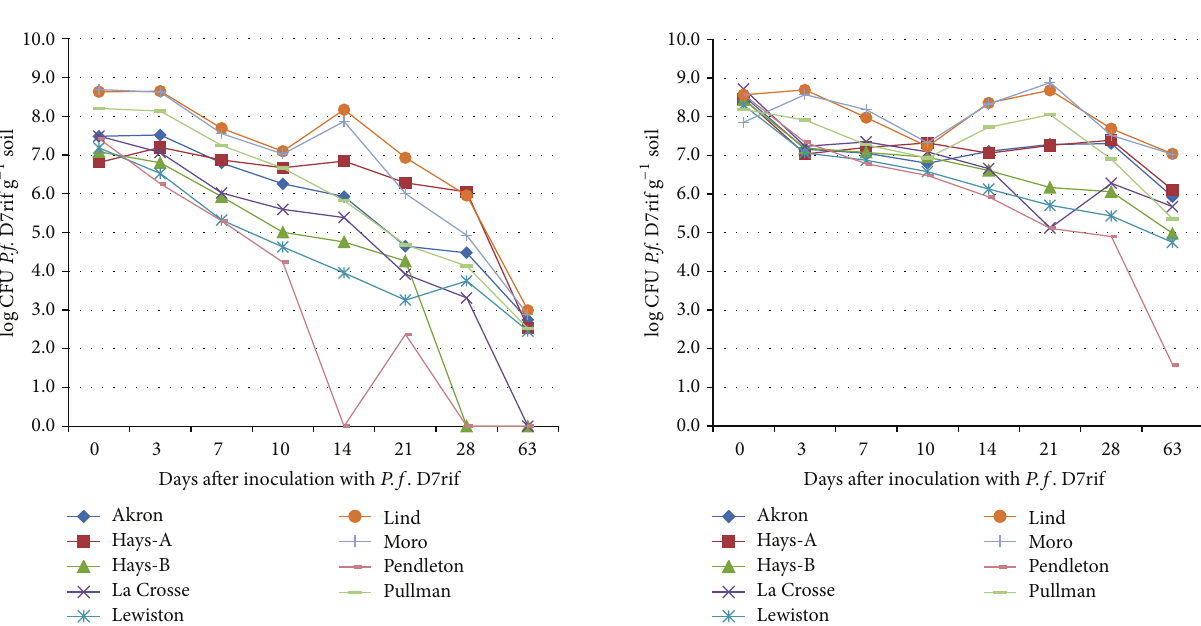
Figure 1: Recovery of P.f. D7rif in log CFU g −1 from nine different soils over a 63-day incubation at 20 ∘ C. A difference greater than log 0.5 indicates significant difference at 𝑃 ≤ 0.05 .